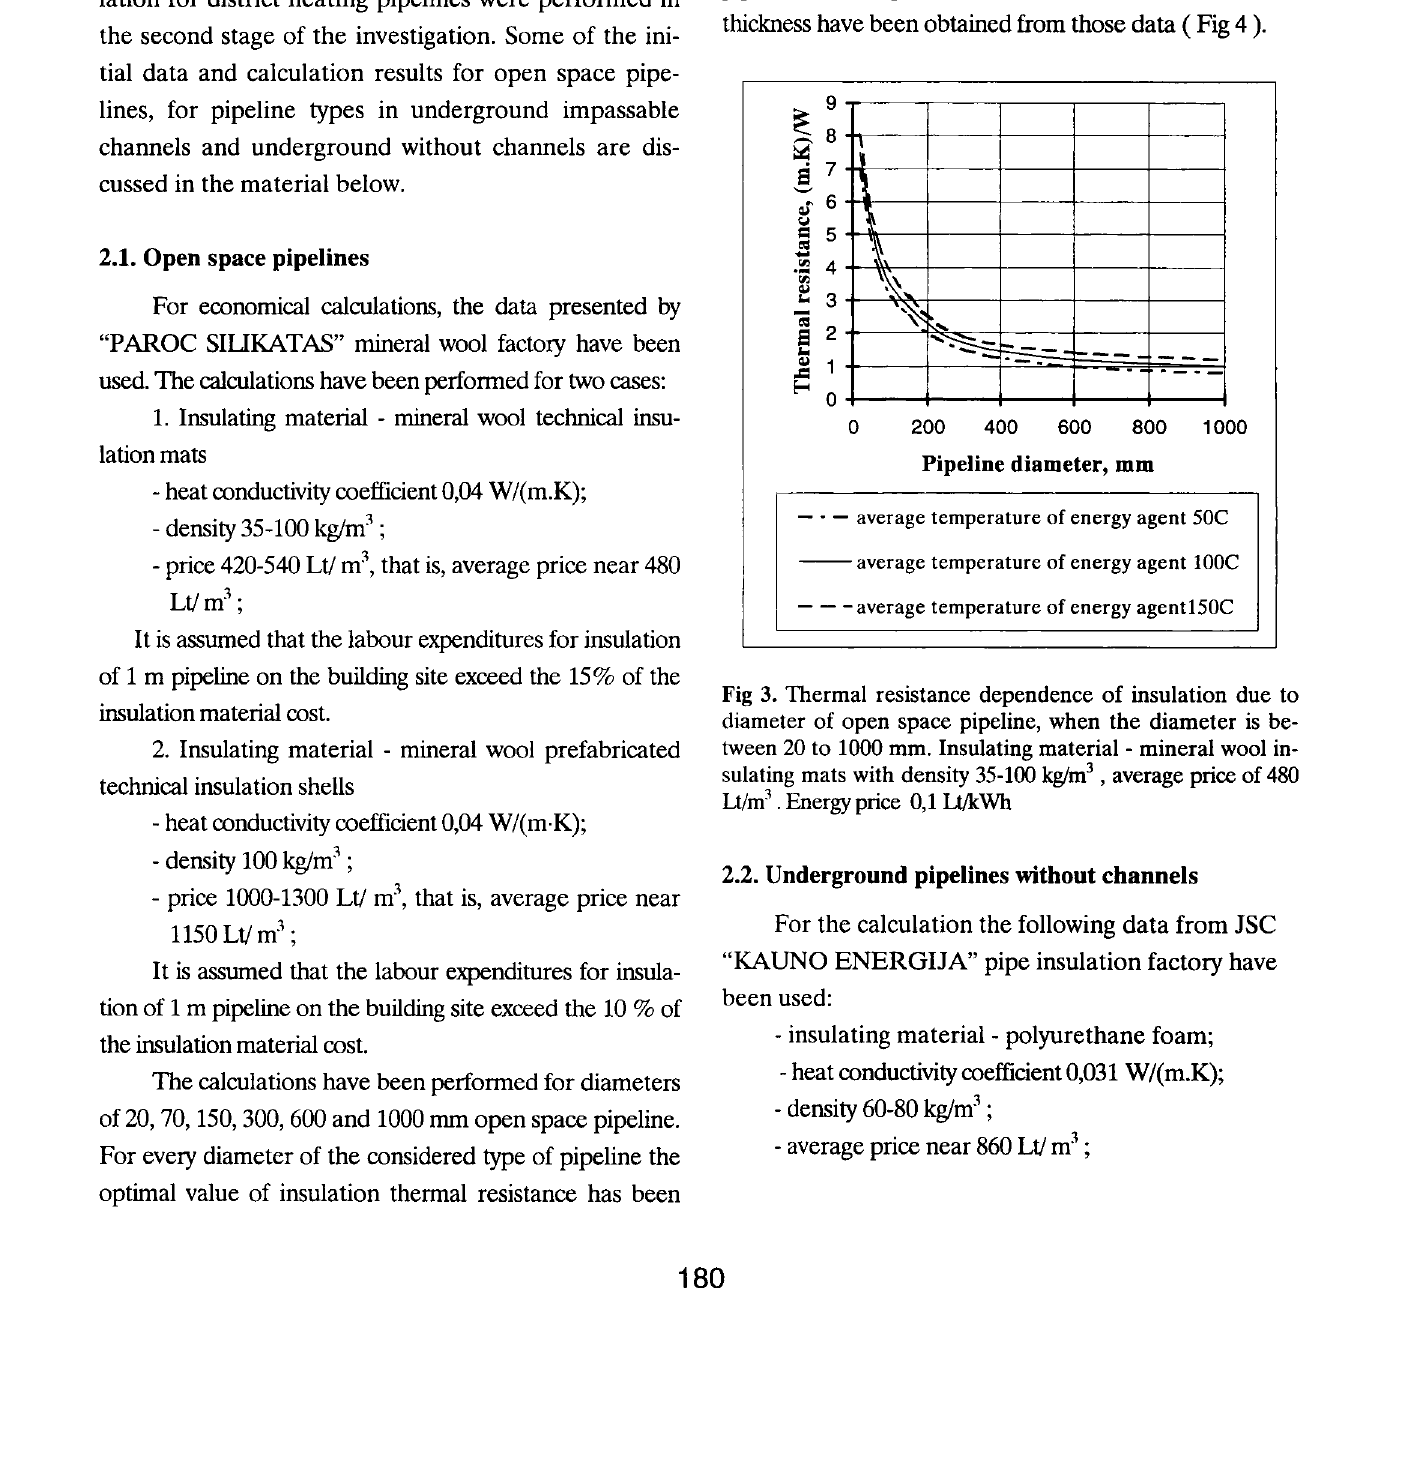
Fig 3. Thermal resistance dependence of insulation due to diameter of open space pipeline, when the diameter is be tween 20 to 1000 mm. Insulating material - mineral wool